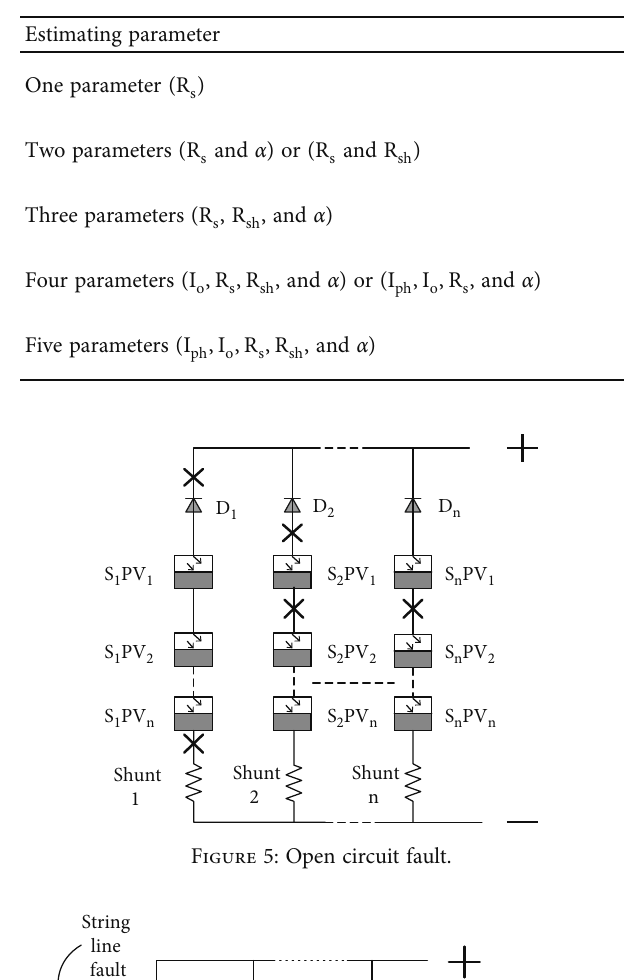
Table 1: References for estimating parameters of SPV.